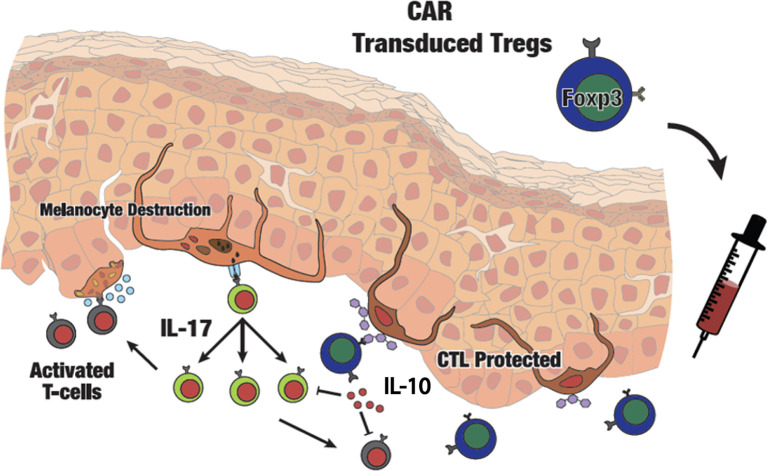
Schematic presentation of adoptive transfer of CAR Tregs in vitiligo. Autoimmune melanocyte destruction is mediated by cytotoxic T cells, which are activated via self-antigens secreted by stressed melanocytes. Elevated IL-17 promotes an inflammatory environment in the skin. Infused GD3-specific CAR Tregs will infiltrate the skin and respond to GD3 expressed at the site of autoimmune activity, suppressing cytotoxic T cells on site and providing local immune tolerance in vitiligo perilesional skin.